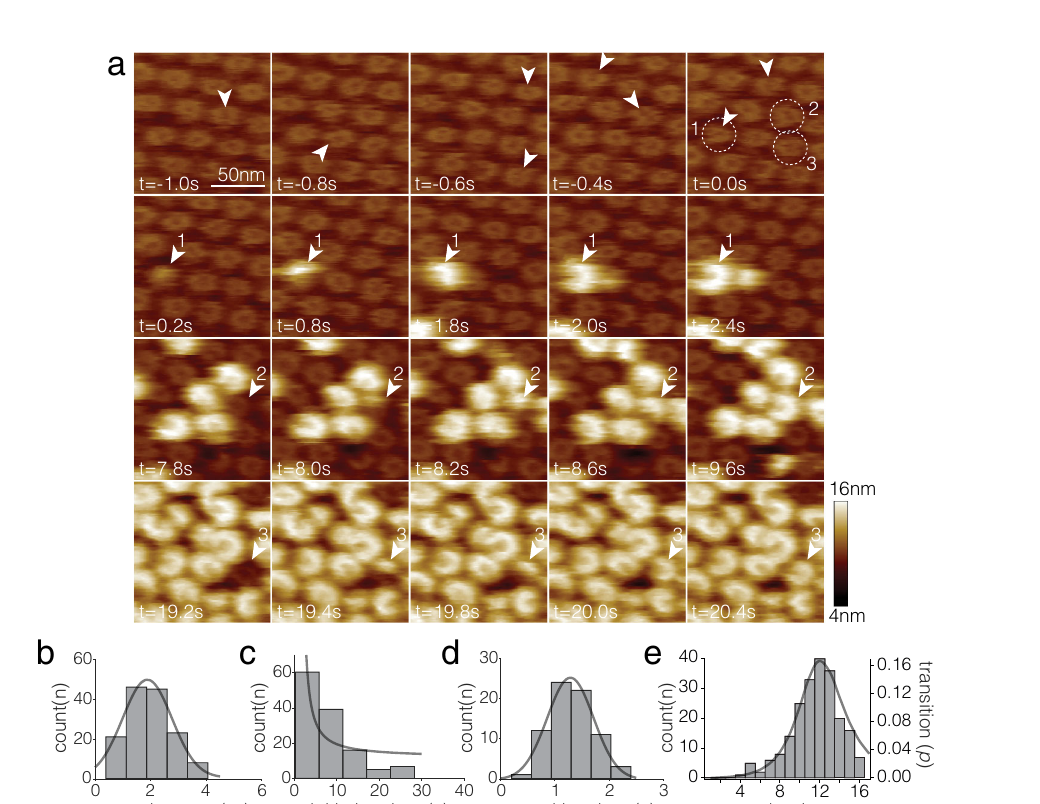
repeats, n =3) and E. coli lipid membrane ( e , experimental repeats, n =10). h , i HS- AFMimagesofPFN2poreoligomersonmica( h ,experimentalrepeats, n =3)and E. coli lipid membrane ( i , experimental repeats, n =10). j Height distribution of pre- pore (mean±std: 8.2nm±0.4nm) and pore (mean±std: 14.0nm±0.5nm) oligo- mersonmica. k Assemblysizedistributionofpre-poreandporeoligomersonmica. l Height distribution of pre-pore (mean±std: 8.1nm±0.2nm) and pore (mean± std:12.1nm±0.6nm)above E.coli lipidmembrane. m Assemblysizedistributionof pre-poreandporeoligomersonlipidmembrane.Thedistributionsin( j , k , l , m )are labeled with the assembly species analyzed and the respective data ( d , e , h , i ). Source data are available as a Source Data fi le.